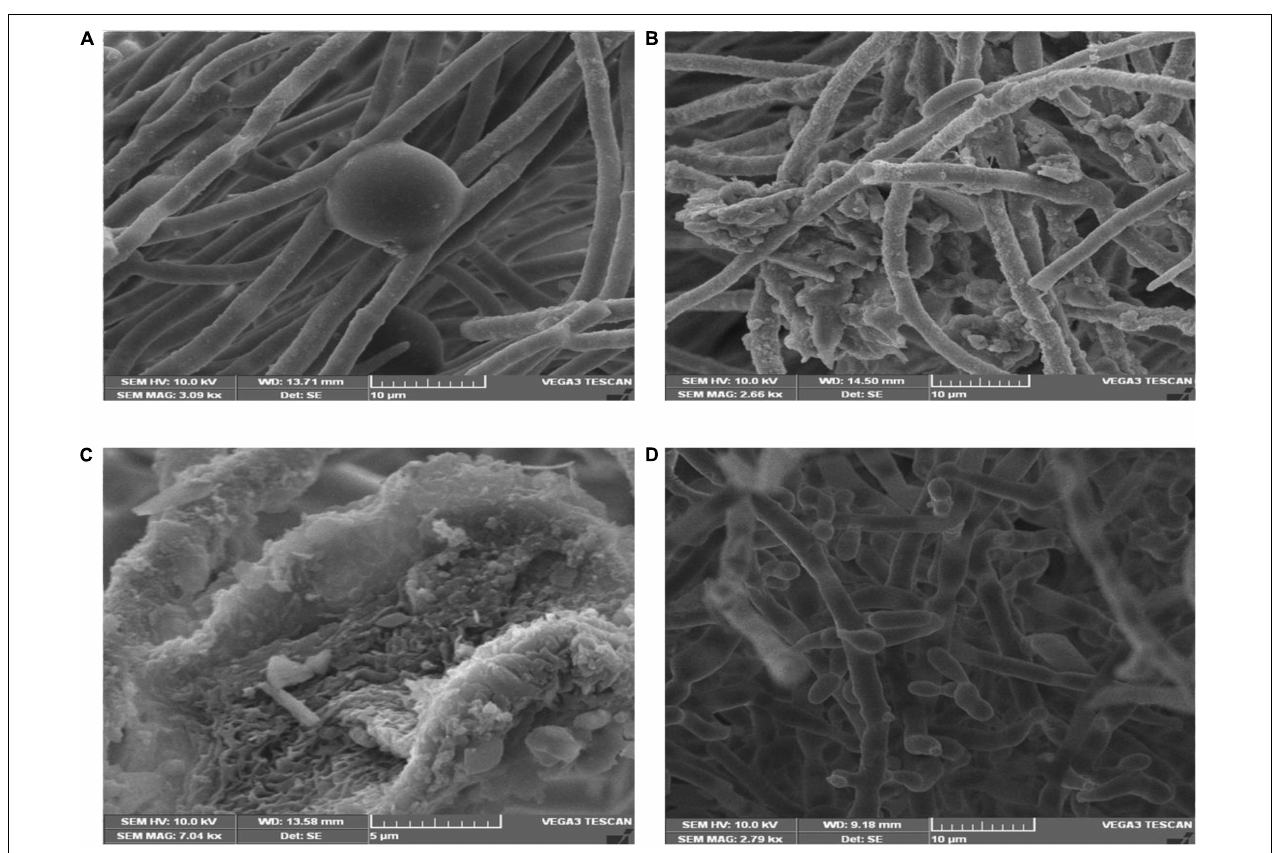
FIGURE 2 | Scanning electron micrographs of mycelia of F. oxysporum f. sp. pisi: in the absence of antagonistic endophytes (A) . In the presence of strain OS_12 only showing dense proliferation of bacteria over the mycelial surface and hyphal destruction (B). In the presence of strain OS_25 only showing adhesion of bacteria to fungus mycelial structure (C) . SEM micrograph of consortium (OS_12 + OS_25) treated mycelia of F. oxysporum f. sp. pisi exhibiting disaggregated hyphal structures with bacterial adhesion and proliferation on mycelial surface (D) . Scale bar equals 10 µ m (A,B,D) and 5 µ m (C)